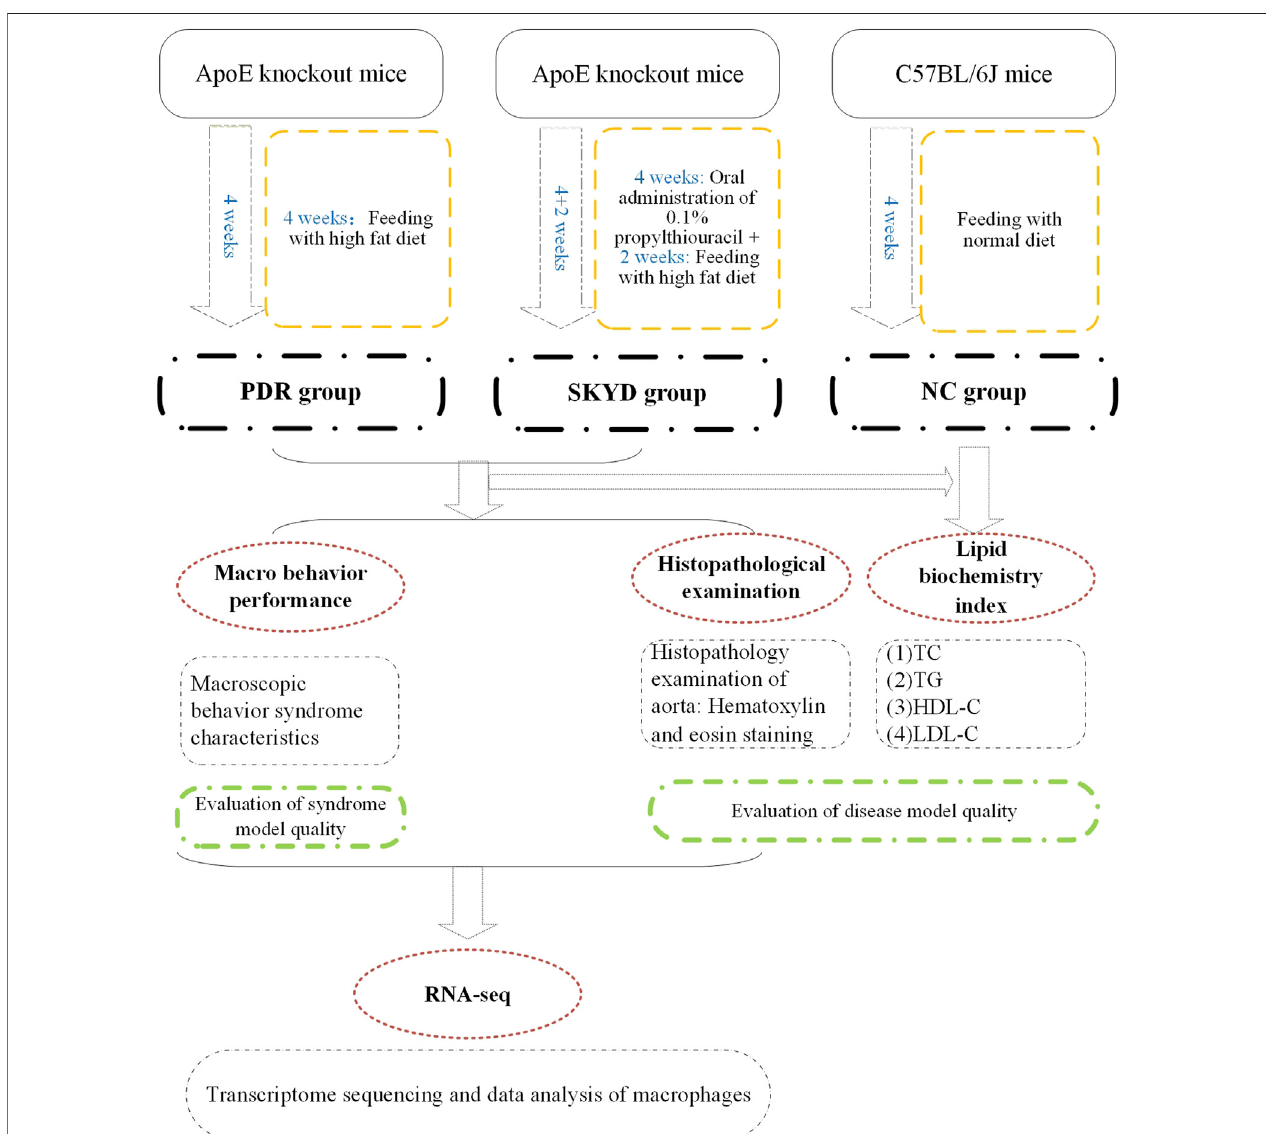
FIGURE 1 | Flowchart of the